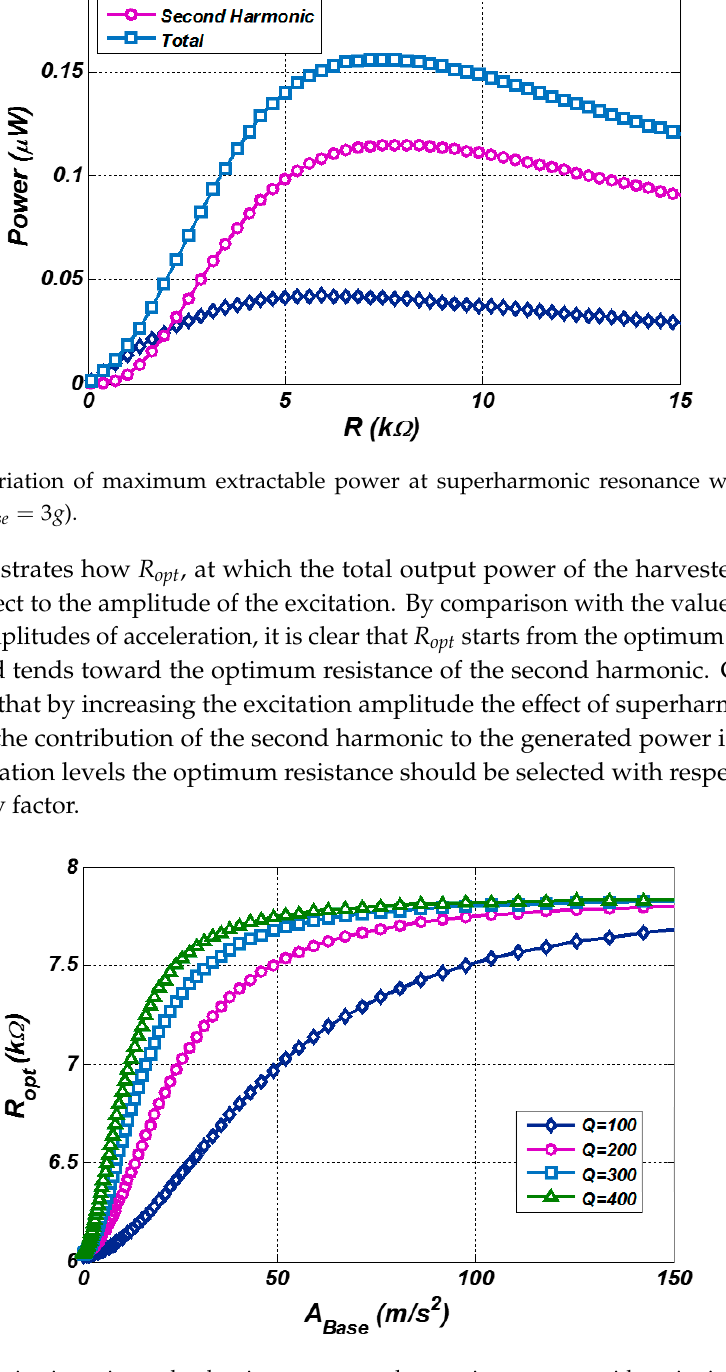
Figure 15. Variation in optimum load resistance at superharmonic resonance with excitation amplitude.